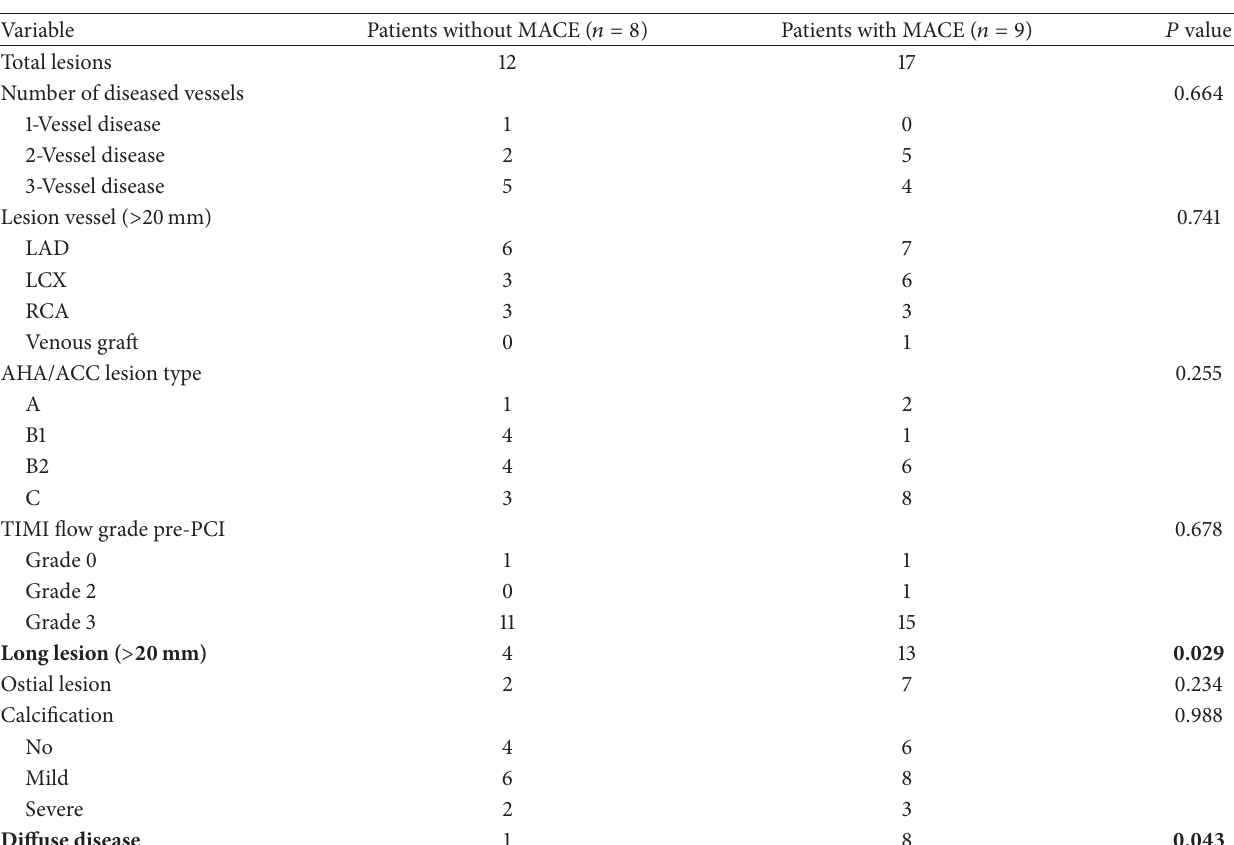
Table 3: (a) Angiographic characteristics. (b) Procedural